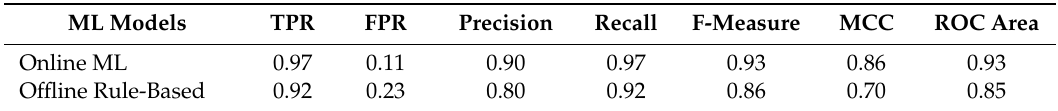
Table 4. Online and o ffl ine use event detection algorithm results when tested against data from the Institutional Review Board (IRB)